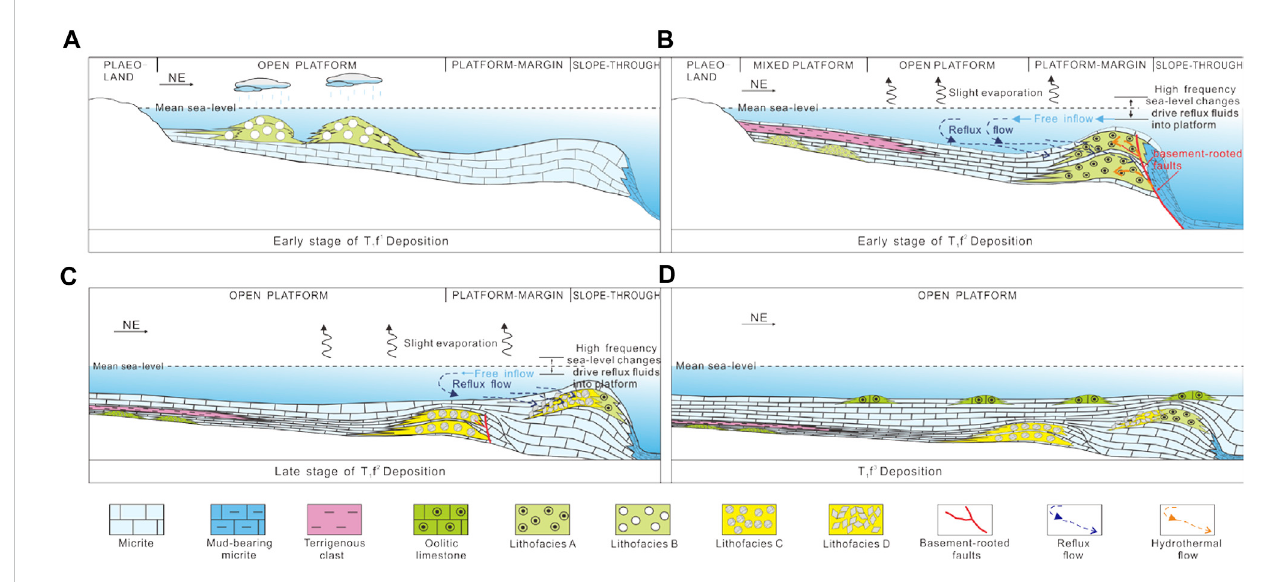
FIGURE 6 Sedimentary-diagenetic evolution model of different lithofacies in Feixianguan Formation tight oolitic